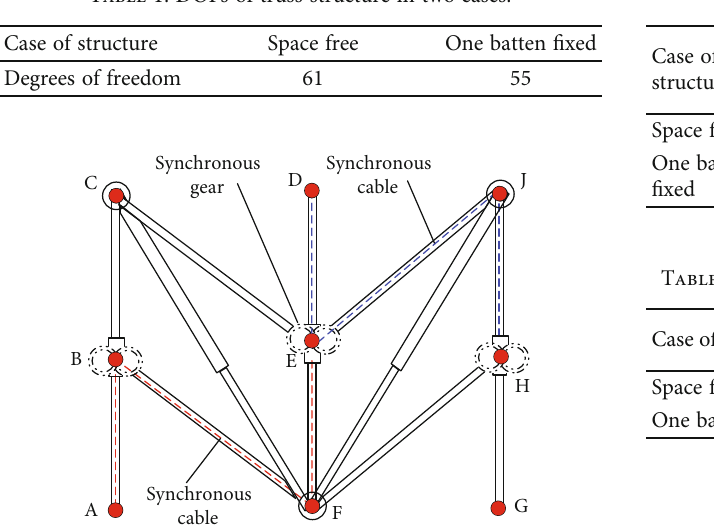
Figure 7: Two di ff erent cases of the ring truss structure. Table 1: DOFs of truss structure in two cases. Table 2: DOFs of truss structure in di ff erent cases.